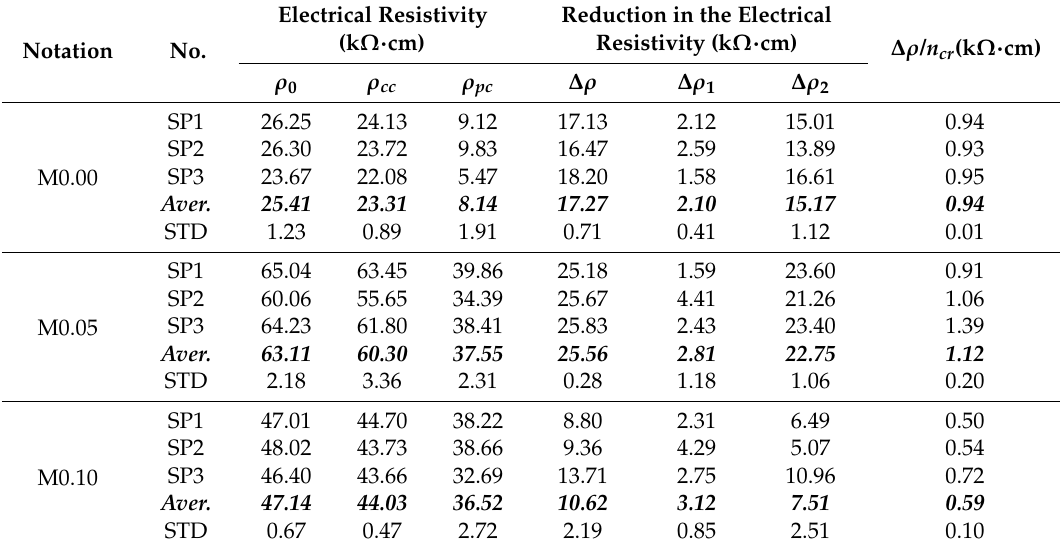
Table 5. Electromechanical parameters of HPFRCCs containing MGFs.